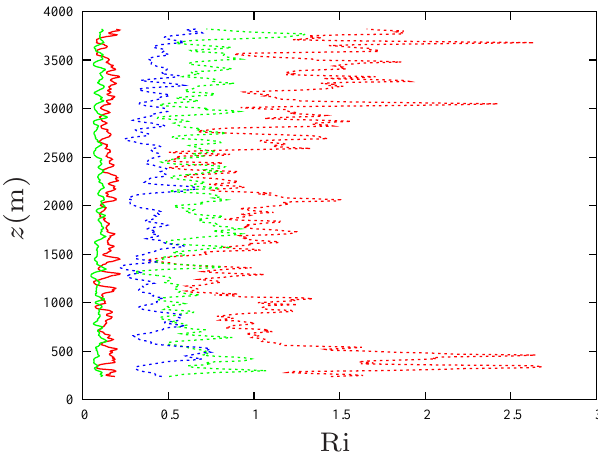
Figure 7. Temporal evolution of the buoyancy length h L b i for the weak forcing cases (red lines), moderate forcing cases (green lines), and strong forcing case (blue line). Solid lines: 1 = 2m; dashed lines: 1 = 4m; dotted lines: 1 = 10m.